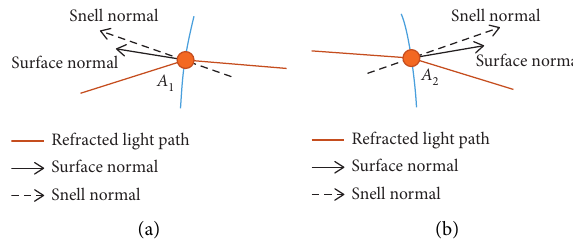
Figure 4: Normal diagram of a surface point of the transparent material. (a) Normal distribution at a point on the front surface. (b) Normal distribution at a point on the rear